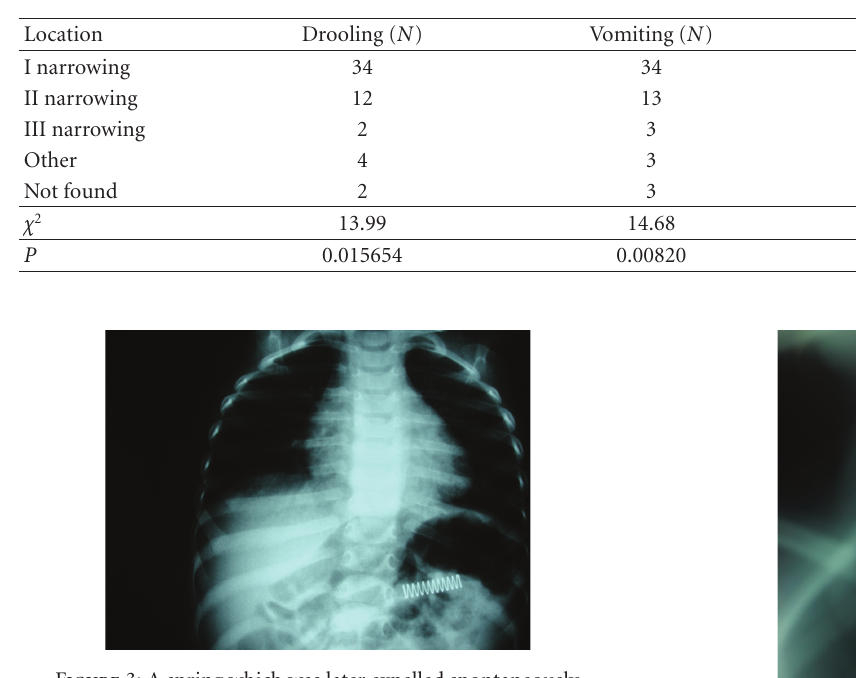
Figure 3: A spring which was later expelled spontaneously.